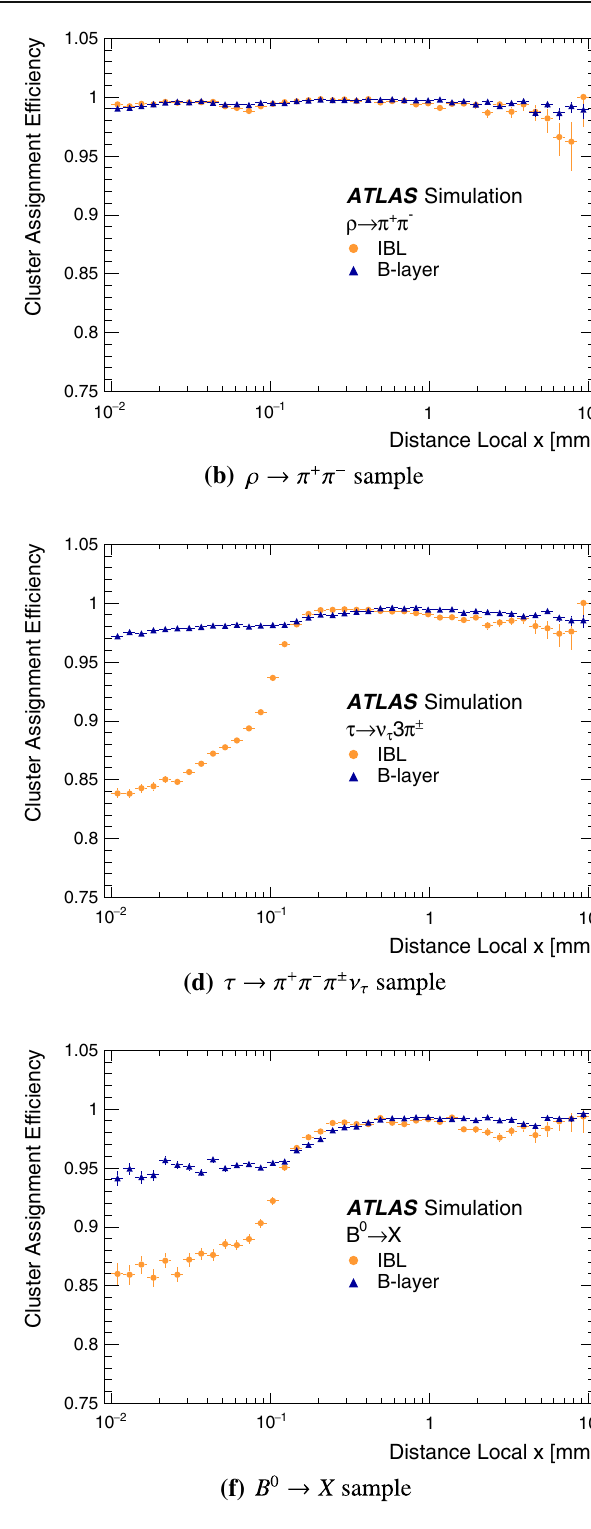
local y (left) and x (right), corresponding to the pixel dimensions lon- gitudinal and transverse to the beam axis. It is required that the stable charged particles are created before the